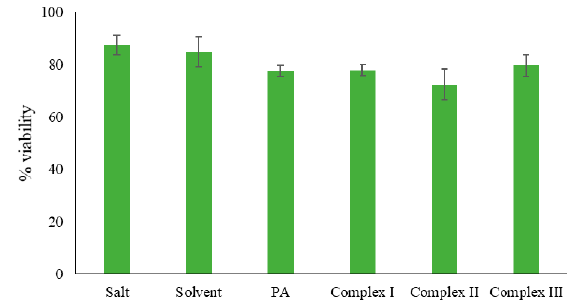
Figure 9. Graphical representation of the viability of Artemia salina after 24 h in the presence of 8 µ g / mL of complexes I , II and III . PA = pipemidic acid. Sample solvent = DMSO (0.08% v / v ).